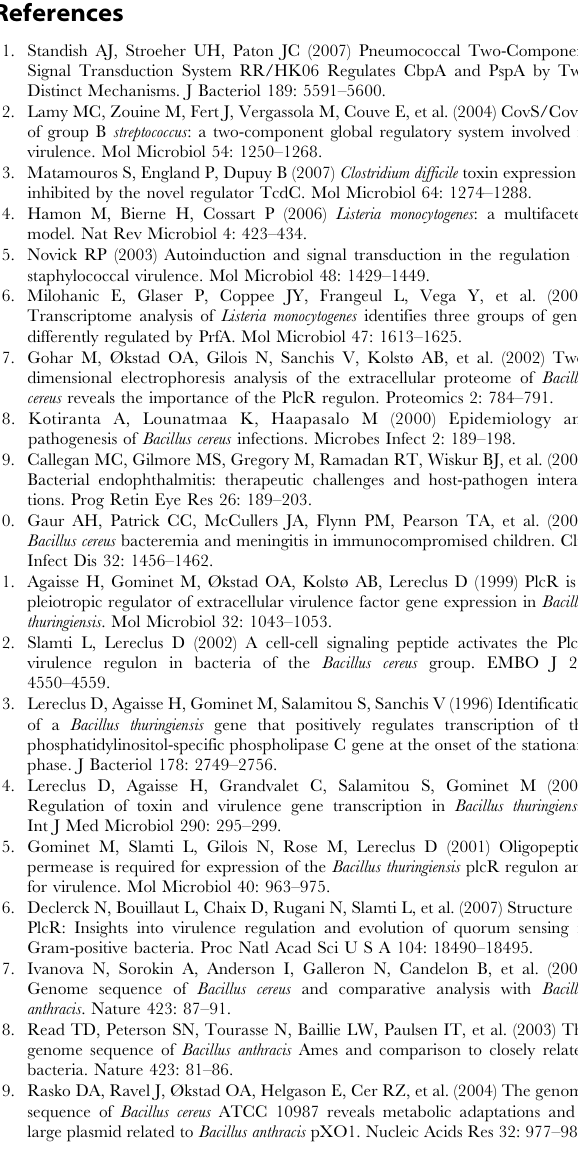
Table S2 Proteins identified in the culture supernatant of the delta-PlcR ATCC14579 strain harvested at t2 Table S3 Primers used for the directed mutagenesis of the PlcR box Found at: doi:10.1371/journal.pone.0002793.s003 (0.04 MB PDF) Table S4 Primers for transcriptional fusions Found at: doi:10.1371/journal.pone.0002793.s004 (0.05 MB PDF) Figure S1 Results from lacZ fusions Found at: doi:10.1371/journal.pone.0002793.s005 (0.13 MB PDF) Figure S2 Two-dimensional gel electrophoresis of the D -plcR ATCC14579 supernatant Found at: doi:10.1371/journal.pone.0002793.s006 (0.97 MB PDF) Figure S3 Location of PlcR boxes on the ATCC14579 chromosome Found at: doi:10.1371/journal.pone.0002793.s007 (0.02 MB PDF) Figure S4 Genetic environment of the 45 PlcR-regulated genes